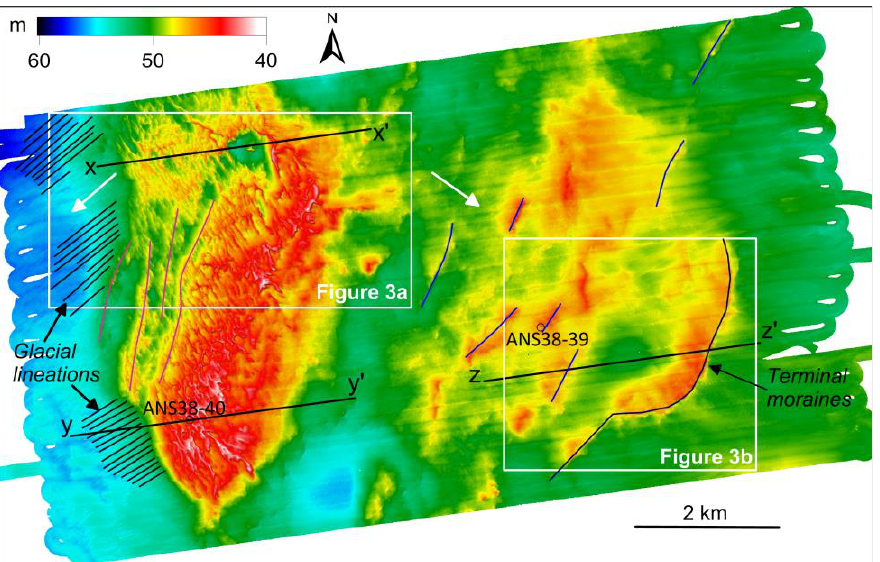
Figure 2. Multibeam bathymetric map of Area 1 in the central part of the Pechora Sea. Sampling points are shown with black rings. White arrows indicate the ice-flow pathways inferred from the glacial landforms.